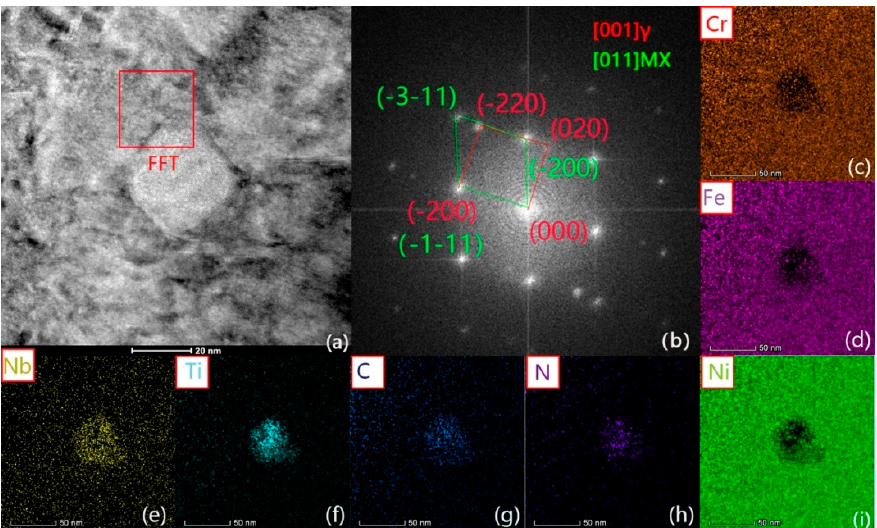
Figure 6. ( a ) The high-resolution transmission electron microscopy (TEM) image of the MX. ( b ) The fast Fourier transform (FFT) of the boxed region in ( a ). ( c – i ) The element content distribution mapping on this visual field.